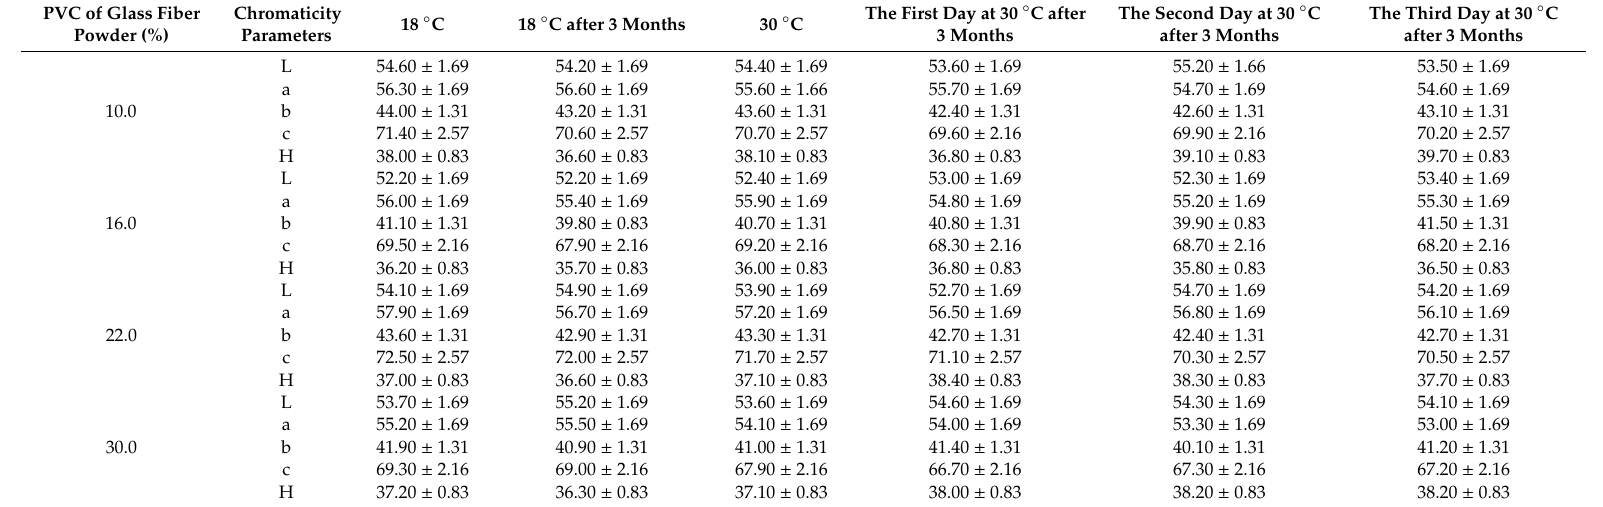
Table 10. Influence of time on chroma change of the waterborne coatings with thermal insulation e ffi